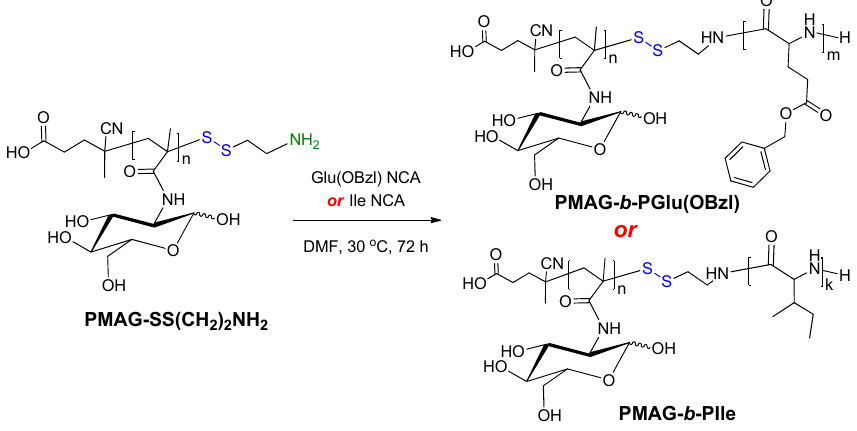
Figure 4. Scheme of synthesis of amphiphilic PMAG- b -P(amino acid).